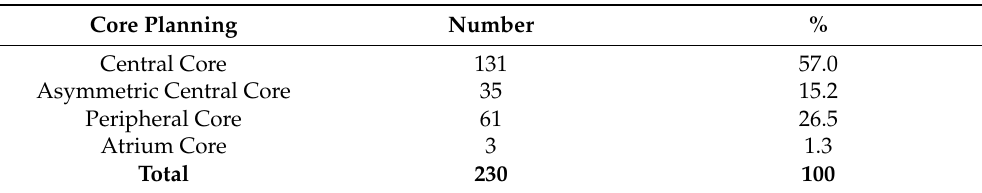
Table 3. Classification of selected tall buildings by core planning.